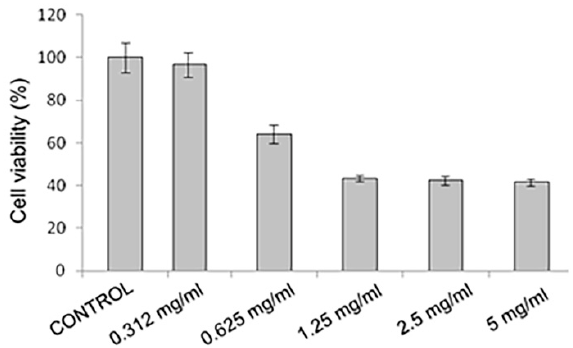
Figure 5. In vitro cytotoxicity analysis using MTT in keratinocytes of the NE-A19 ( p > 0.05).